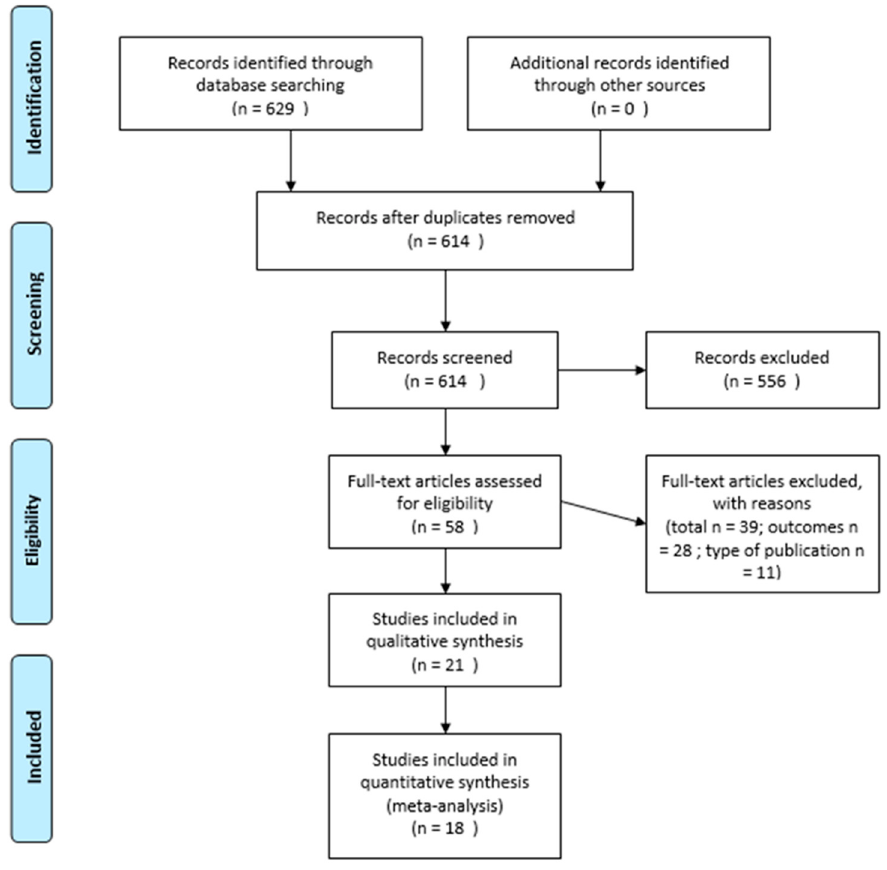
Figure 2. Details of the study selection—PRISMA flow chart of literature search.